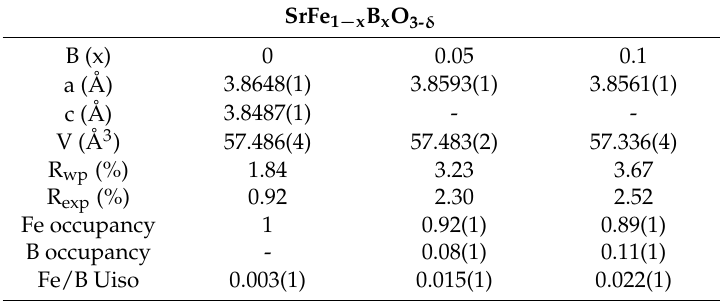
Table 4. Lattice parameters and Fe/B site occupancies obtained from Rietveld analysis using X-ray